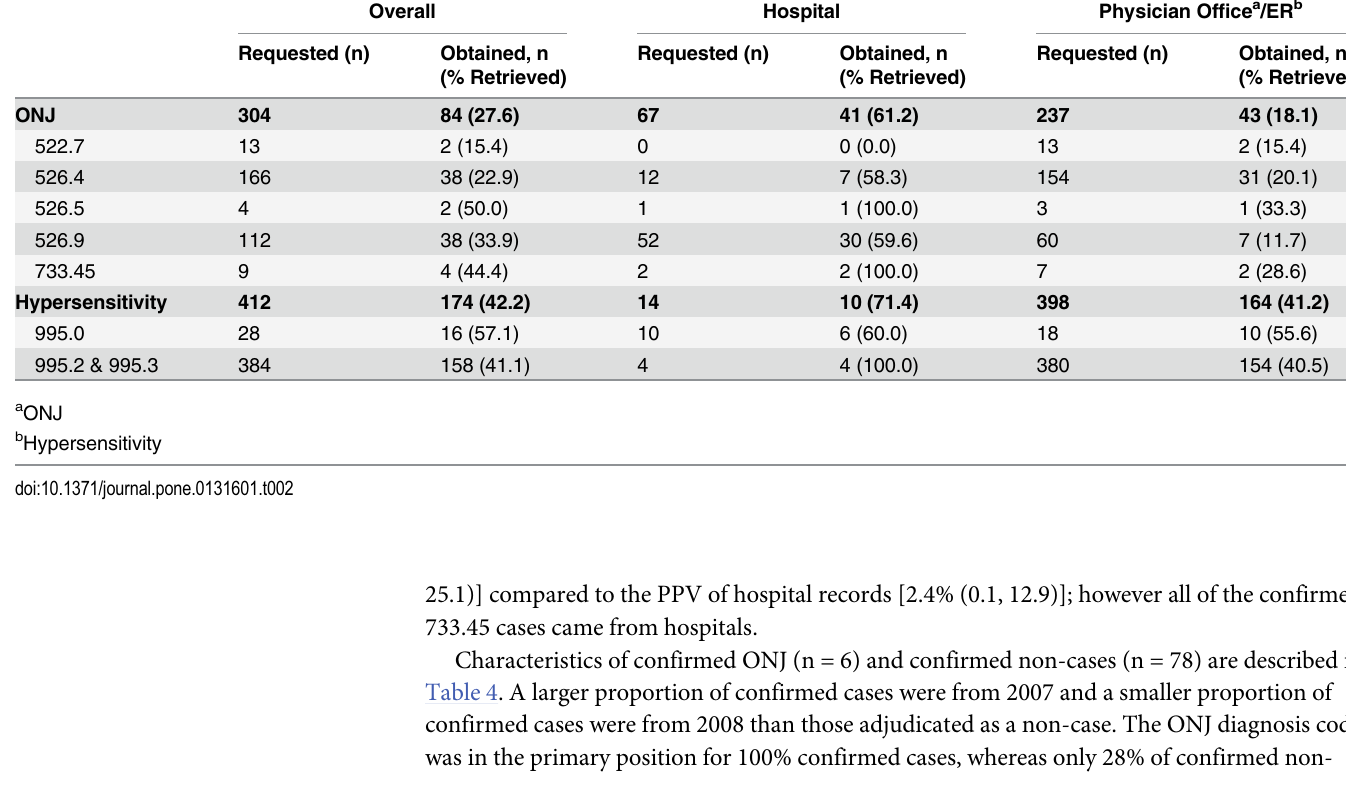
Characteristics of confirmed ONJ (n = 6) and confirmed non-cases (n = 78) are described in Table 4. A larger proportion of confirmed cases were from 2007 and a smaller proportion of confirmed cases were from 2008 than those adjudicated as a non-case. The ONJ diagnosis code was in the primary position for 100% confirmed cases, whereas only 28% of confirmed non-